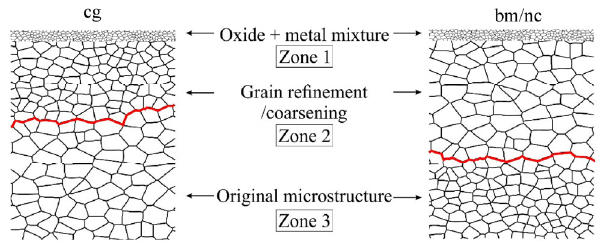
Fig. 8 Schematic representation of the usually observed microstructural regions in dry sliding. The microstructures are represented with an arbitrary scale.